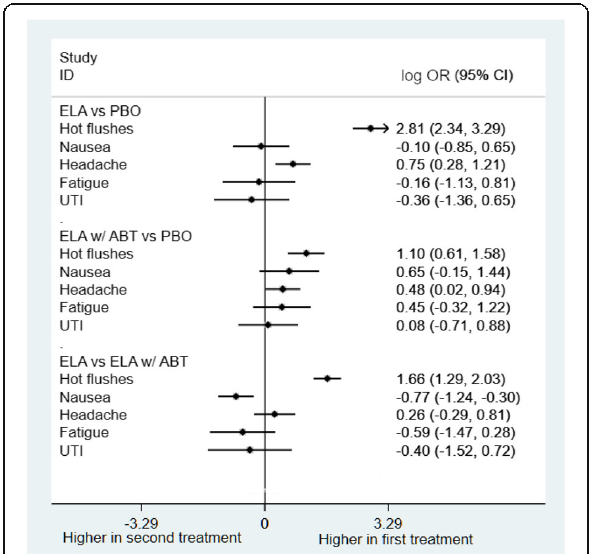
Fig. 7 Pooled effect estimates (log OR) for selected adverse events according to treatment